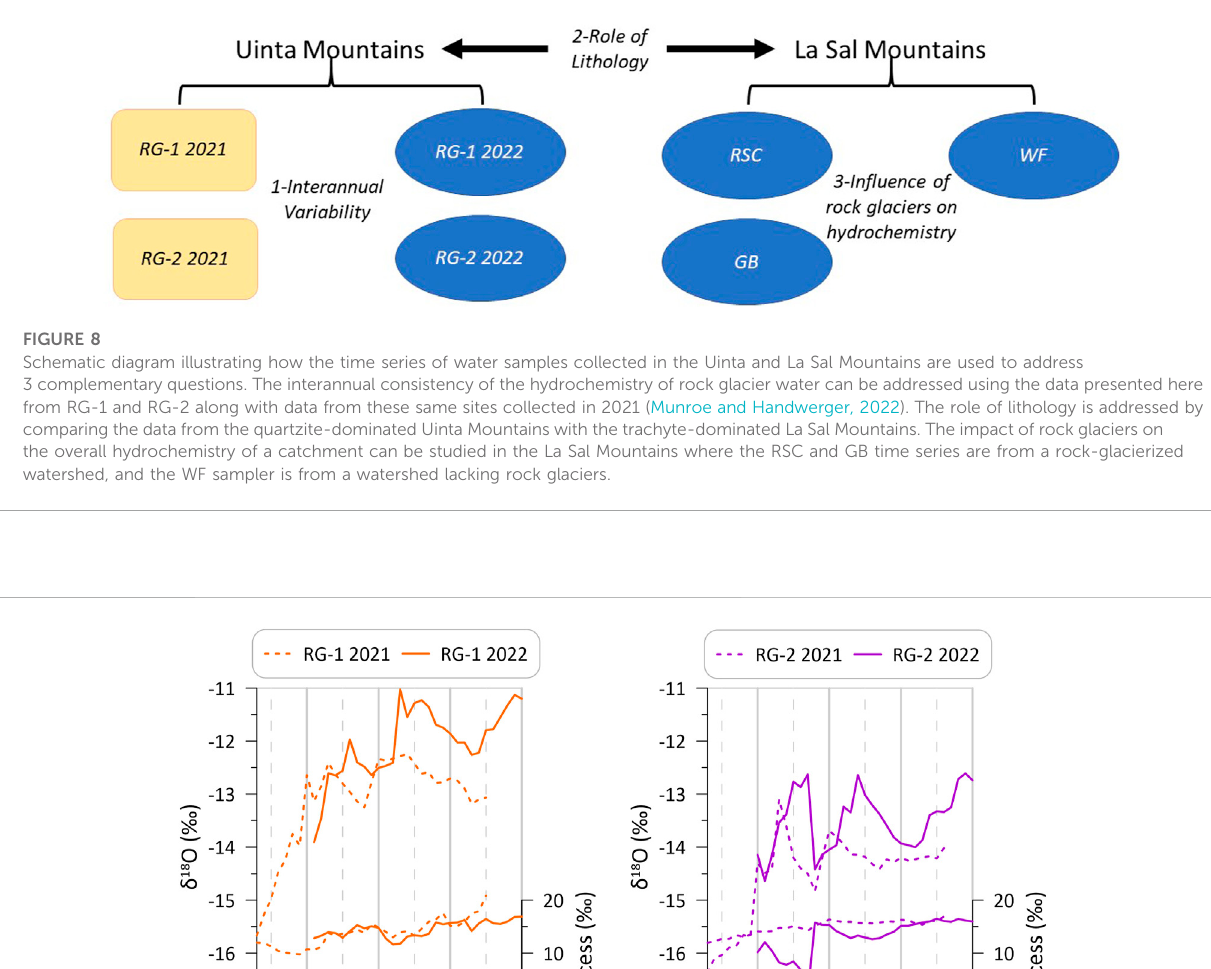
Frontiers in Earth